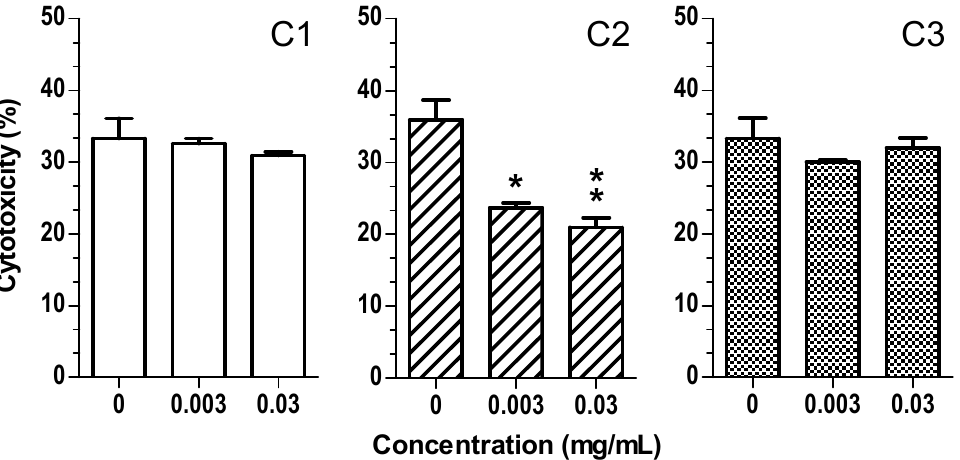
Figure 7. C2 extract reduces the cytotoxicity induced by SDS in HaCaT cells. Cells were treated with various concentrations of extract (0.003–0.03 mg/mL) for 2 h and then treated with SDS (140 µ M) for 24 h. At the end of treatment, cell viability was evaluated by MTT assay, as described in the method section. Data are expressed as percentage of control cells and expressed as mean ± SEM of four independent experiments (* p < 0.05, ** p < 0.01 vs. cells treated with UVA; one-way ANOVA with Dunnett post hoc test).